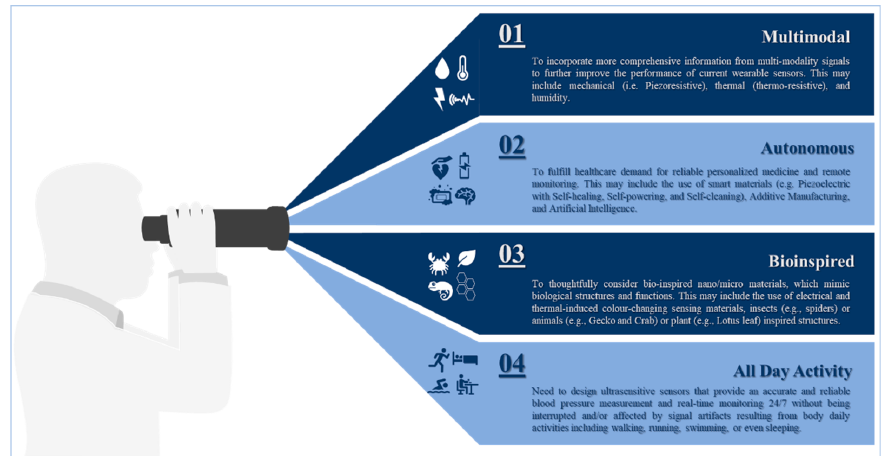
Figure 22. Summary of future development in the field of blood pressure measurement and real-time monitoring.